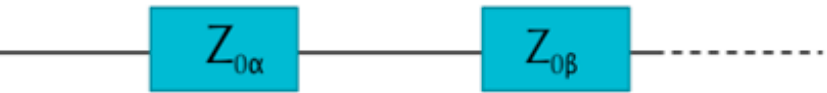
Figure 3. Transmission model.